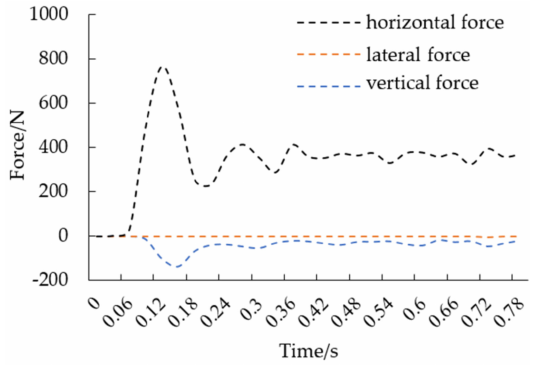
Figure 11. Three-axis working force curves of bionic press